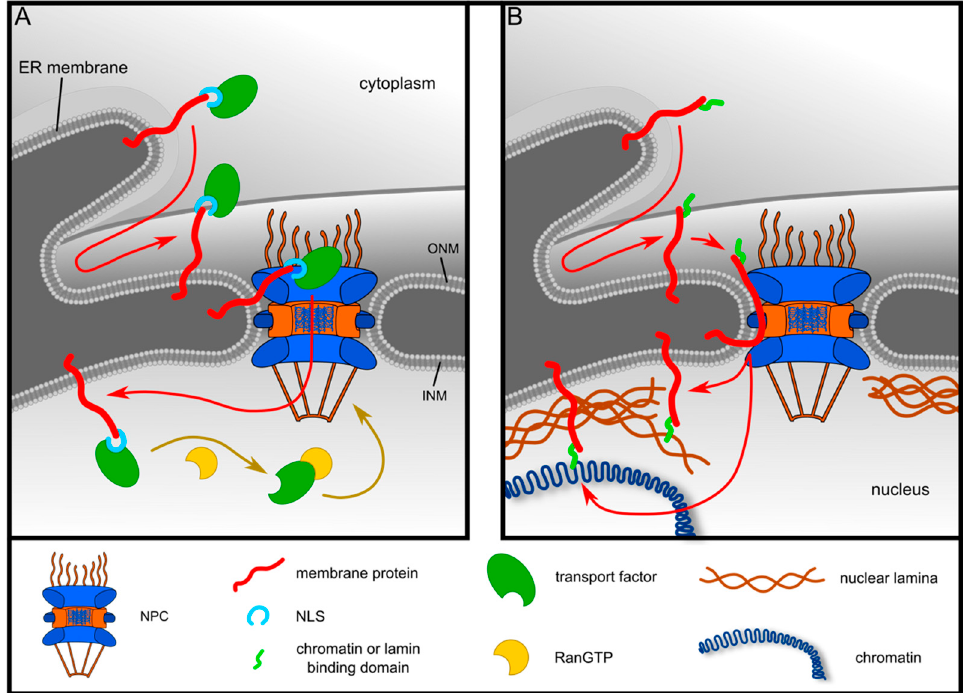
Figure 1. Models for targeting of membrane proteins to the inner nuclear membrane. ( A ) Active-transport-model. After insertion into the endoplasmic reticulum (ER), proteins expose a nuclear localization signal (NLS) to the cytoplasm, which can be recognized by nuclear transport receptors. After translocation from the outer nuclear membrane (ONM) to the inner nuclear membrane (INM), the complex is dissociated by nuclear RanGTP. ( B ) Diffusion-and-retention model. Membrane proteins diffuse passively through the nuclear pore complex (NPC) and are sequestered at the INM upon interaction with the nuclear lamina and/or chromatin. See text for details. Modified after reference [29].